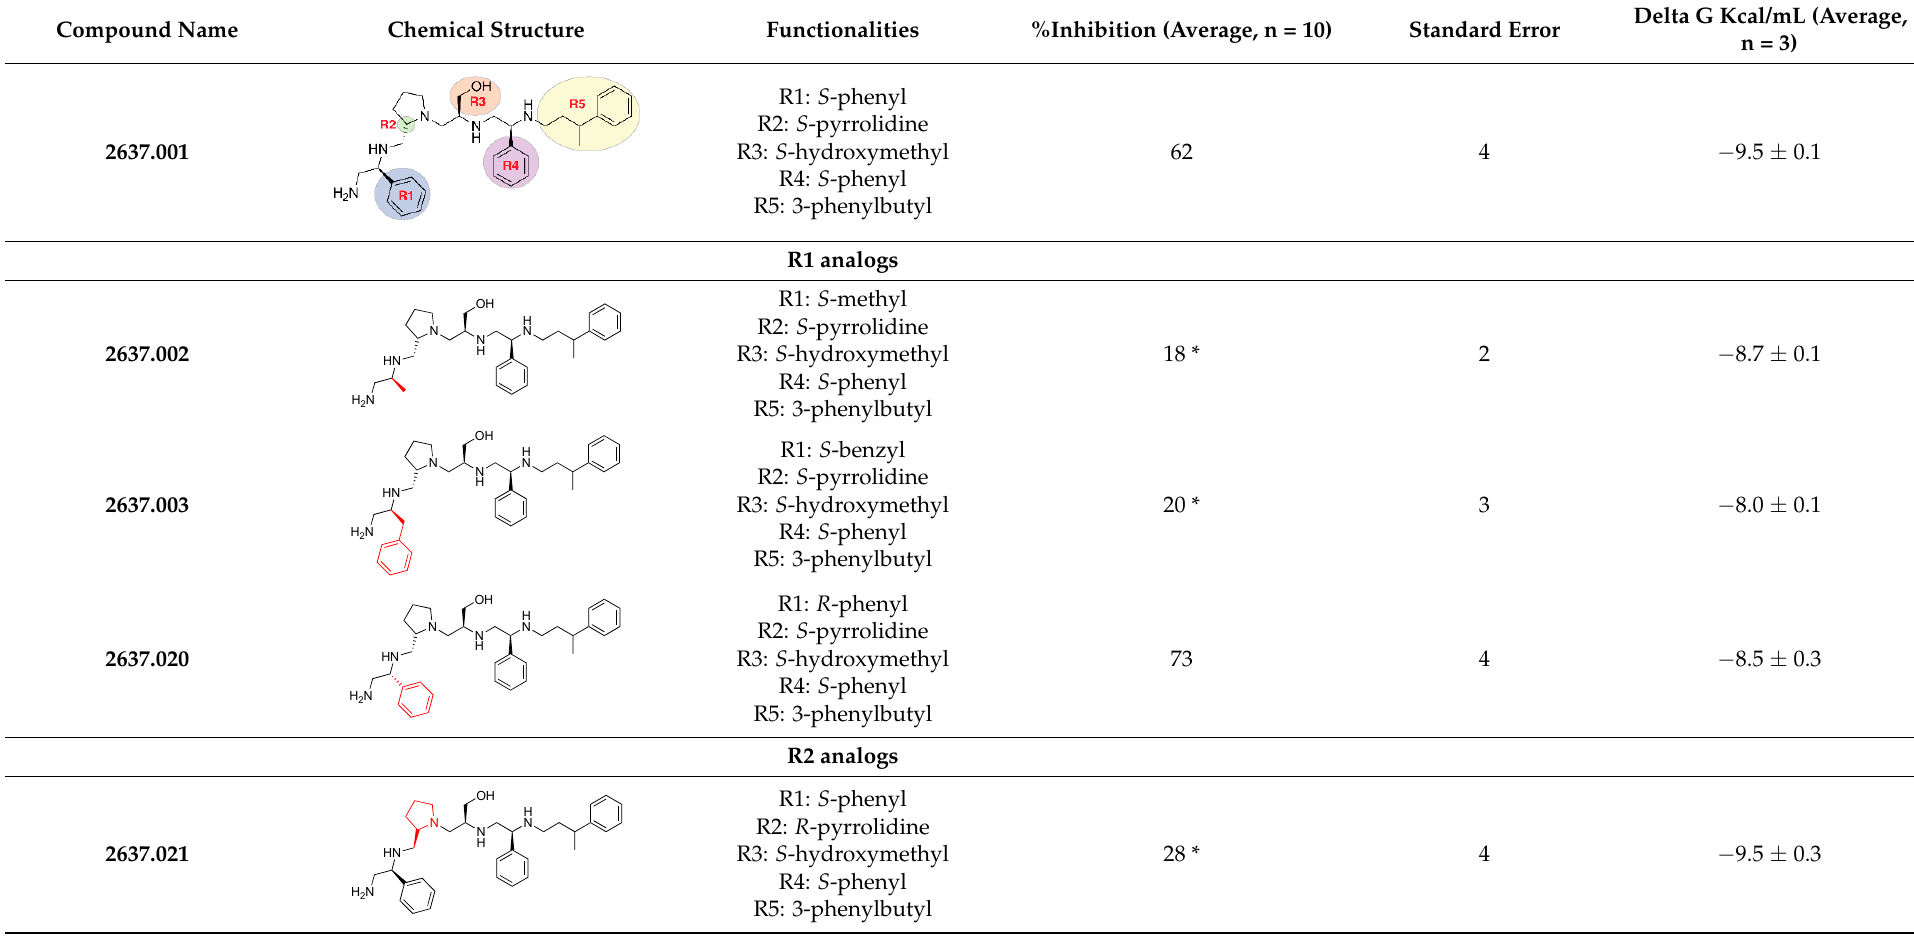
Table 1. Properties of 2637.001